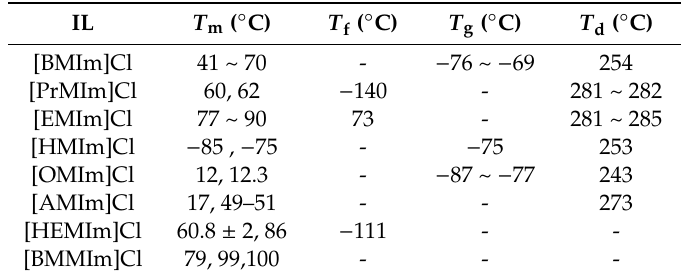
Table 5. Thermodynamic transition temperatures of common imidazolium-based ILs and those used in the